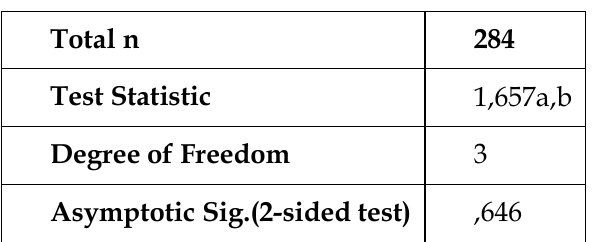
Table 11. Concern about breaching privacy and education. Independent Kruskal-Wallis sig. test. The test statistic is adjusted for ties.